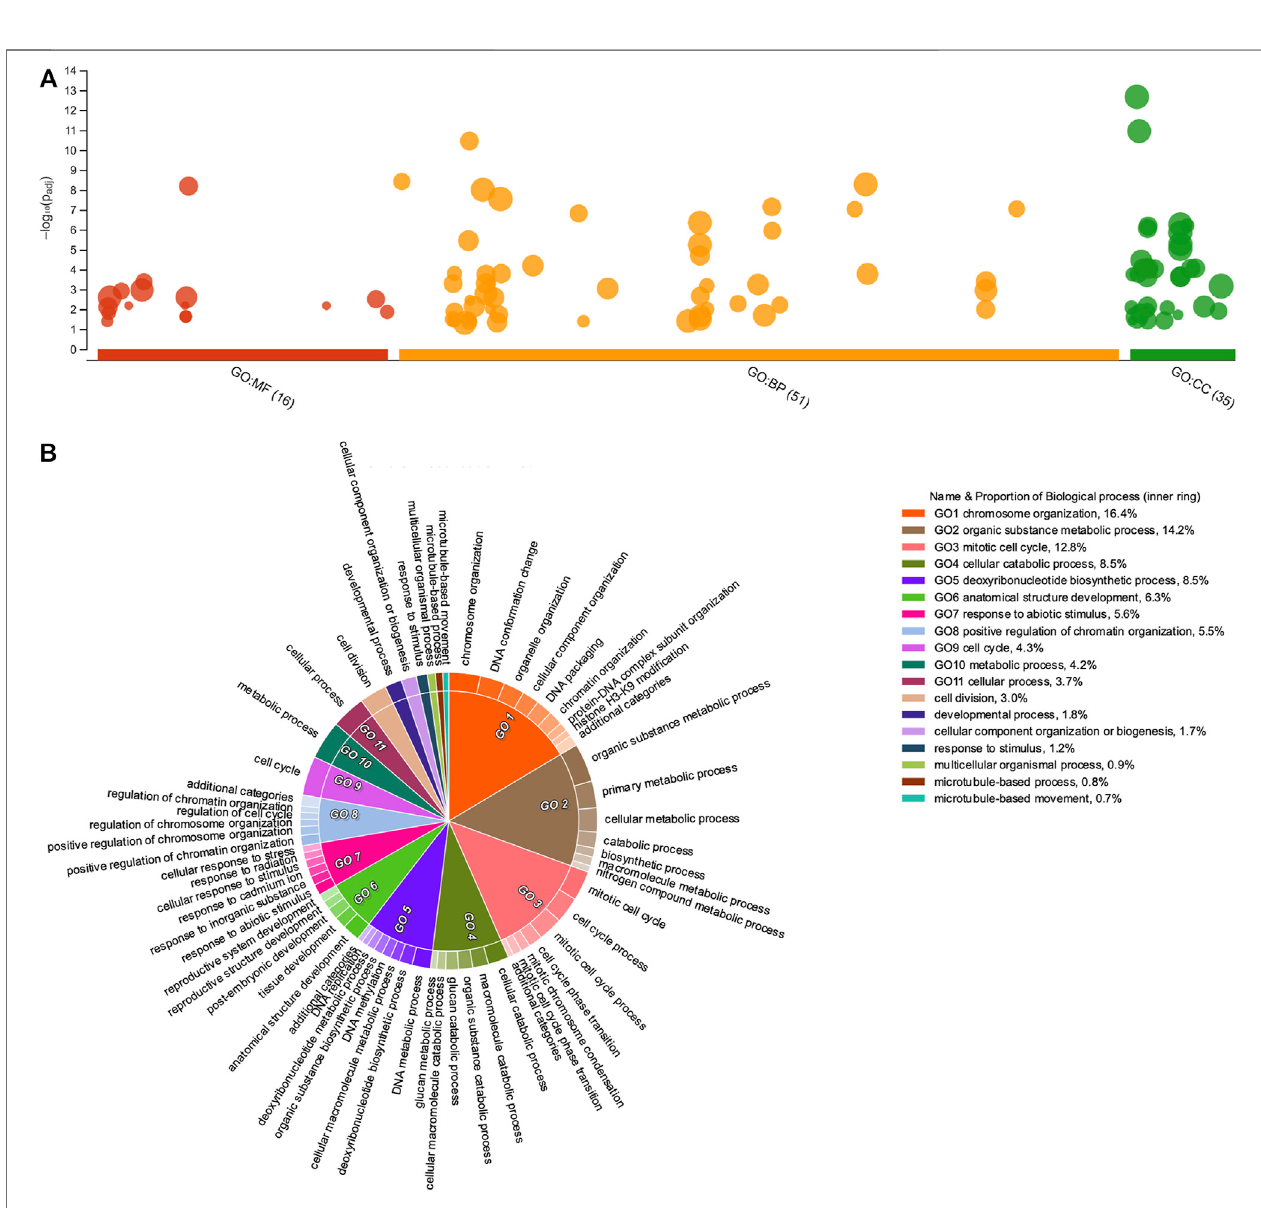
FIGURE 4 | Gene Ontology enrichment of upregulated Psittacanthus schiedeanus uniGenes and involved in compound endosperm development after seed germination. (A) Manhattan plot illustrating the GO enrichment analysis results separated into the three major categories: MF (molecular functions), BP (biological processes), andCC (cellularcomponents).Thenumber inthesourcenameinthe x -axis labelsshowshow manyGOterms weresigni fi cantlyenriched (g:SCSthreshold, p -value ≤ 0.05). (B) BiologicalprocessesCirGOvisualizationplot.Intensityshadesofcoloredcategoriesre fl ecthierarchicalrelationsbetweenGOclassesthatwere found enriched. Each subclass is represented in the plot by a white divisor line within each parent class, i.e., solid colors of the central pie charts. Features identities and names of all enriched functional categories (GO-terms) are reported in Supplementary Table S10 .